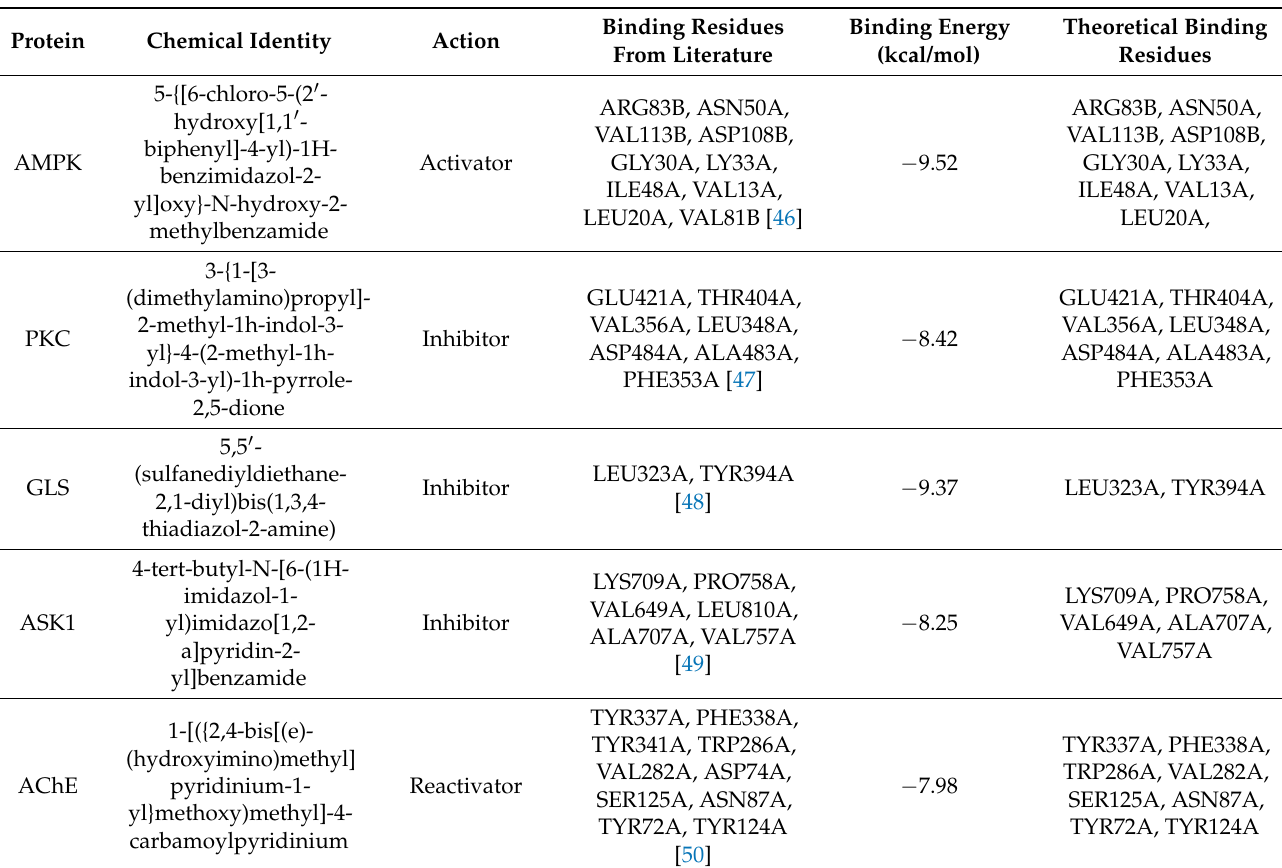
Table 2. The comparison between the binding site residues found in literature and theoretical binding residues found by